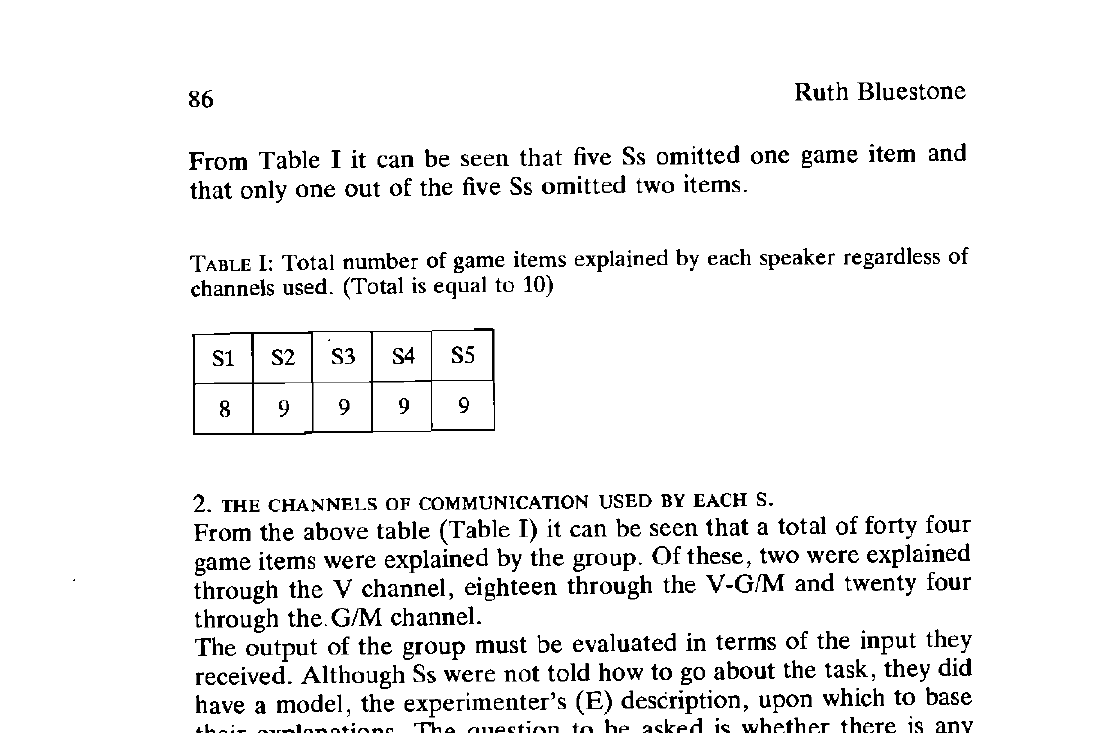
TABLE I: Total number of game items explained by each speaker regardless of channels used. (Total is equal to 10)